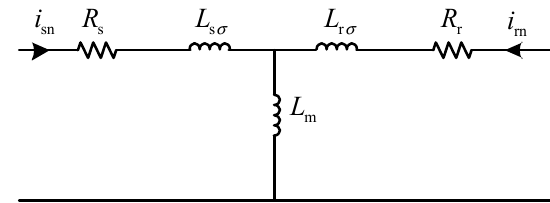
Figure 4. Equivalent circuit of the DFIG.